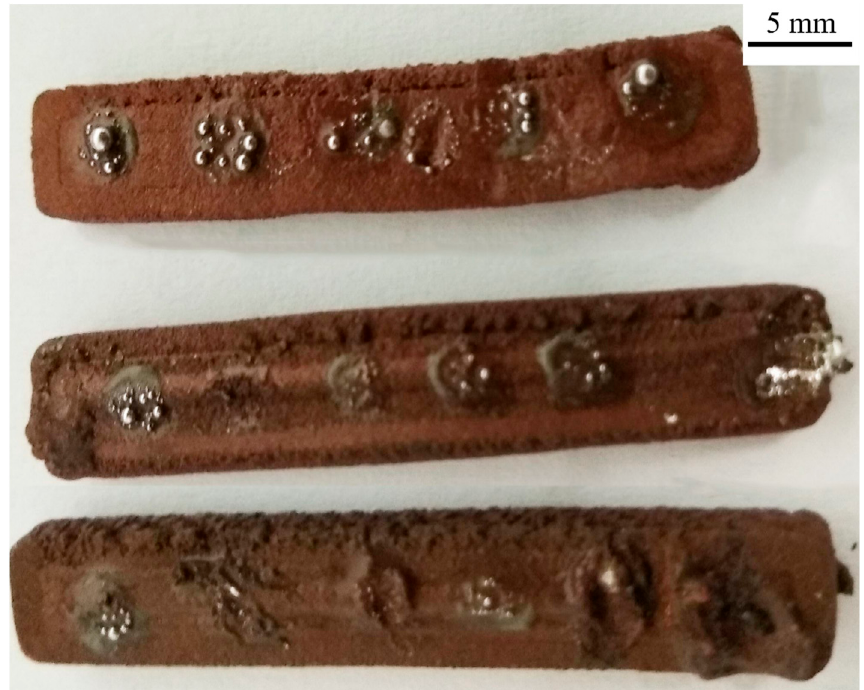
Figure 4. Results of hot iron soldering with low-temperature SnBiAg solder paste on different composites (from top: PLA/Cu, ABS/Cu, Ps/Cu).